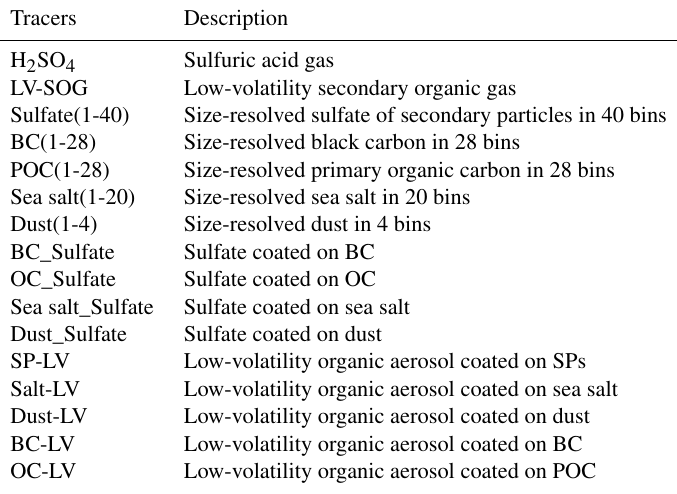
Table 1. The newly added tracers for simulation in microphysical